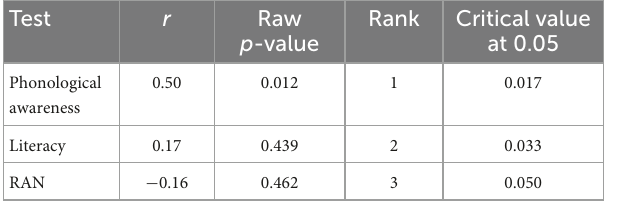
TABLE 6 Correlations in the control group between the test performance and MMN amplitude change after training with the